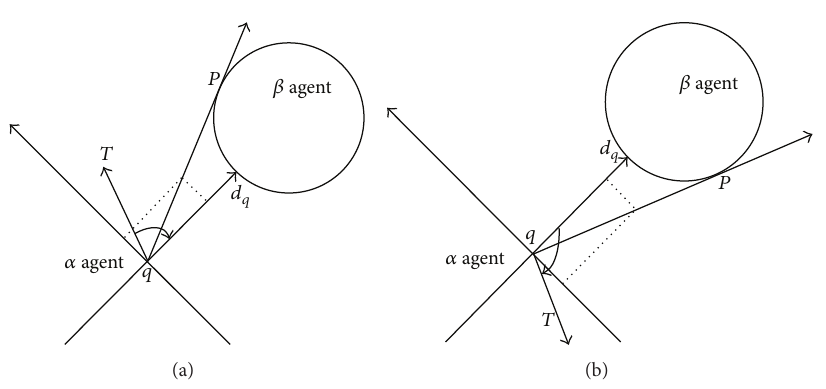
Figure 3: The relative position relationship between agent and obstacle.